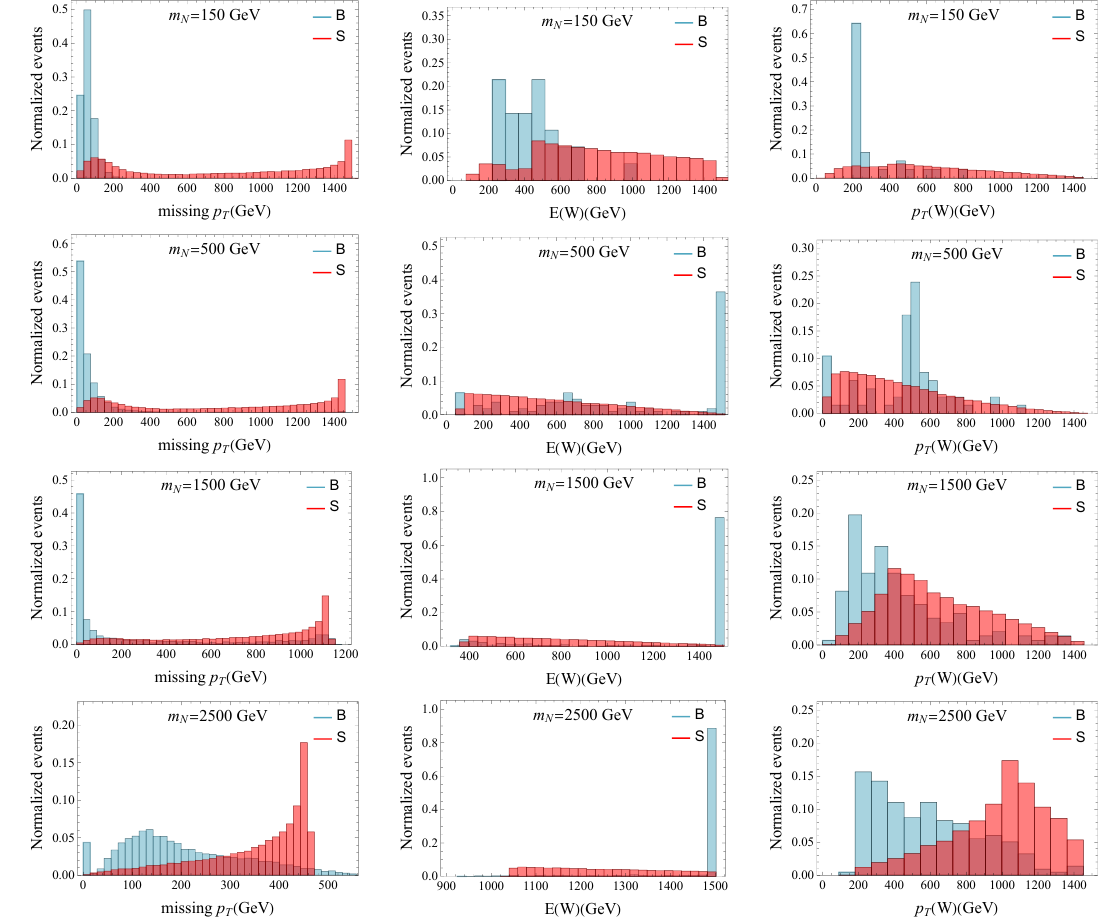
Figure 7 . The normalized signal and background distributions e -flavored HNL at 3 TeV. The left column refers to the missing p T distribution after pre-selection and central W cut. The middle column refers to E ( W ) distribution after missing p T cuts. The right column refers to p T ( W ) distribution after E ( W ) cut. Blue and red bins represent background and signal distributions,